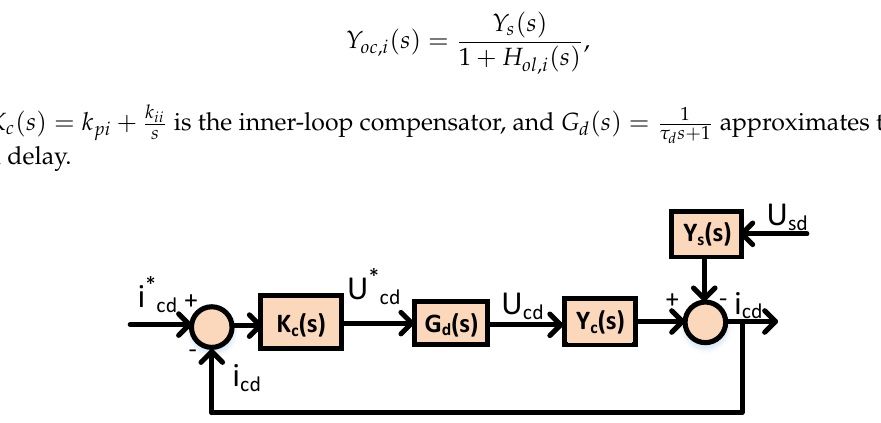
Figure 4. Analytical block diagram of the d -axis current